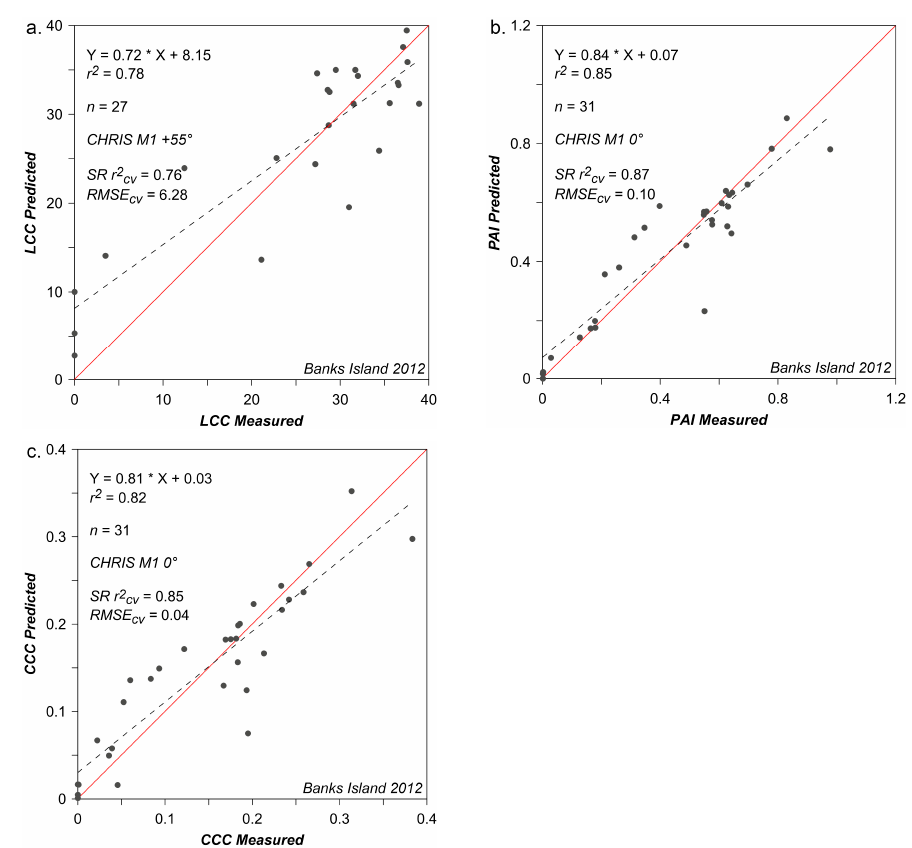
Figure 4. Scatterplots showing measured vs. predicted relationships for the best locally developed SR modelling outputs for Banks Island, 2012. Root mean squared error (RMSE) units: ( a ) leaf chlorophyll content, LCC ( μ g/cm 2 ); ( b ) plant area index, PAI (m 2 /m 2 ); ( c ) canopy chlorophyll content, CCC (g/m 2 ). Normalized root mean squared error (NRMSE) = RMSE/range of measured data. The 1:1 identify line (red) is shown in each scatterplot to provide a comparative reference.